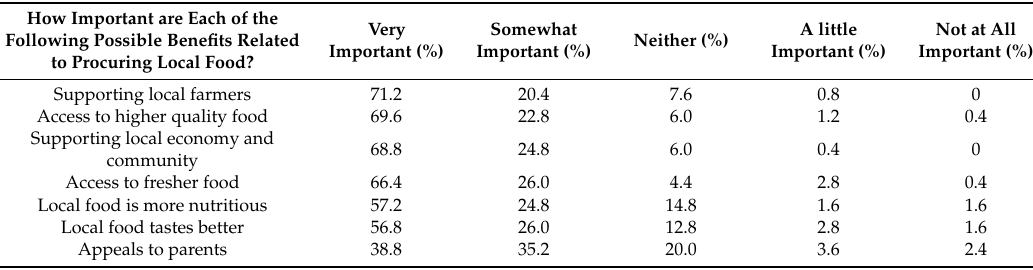
Table 1. Perceived benefits of local food procurement among licensed Colorado Early Care and Education (ECE) providers 1 .